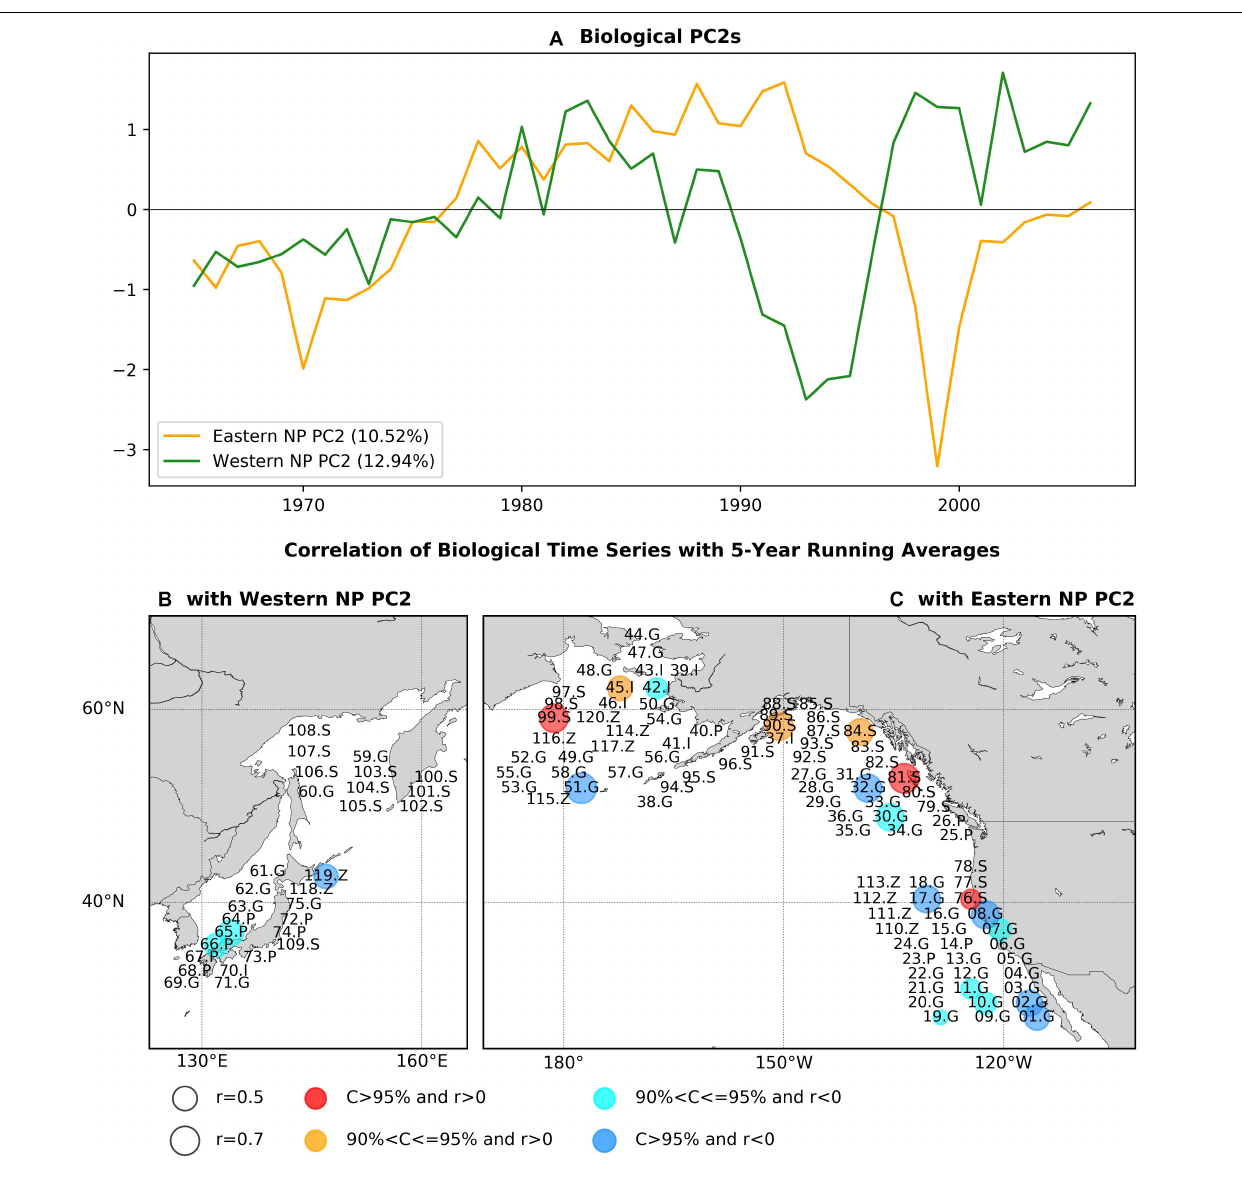
FIGURE 4 | As in Figure 2 , but for the PCA second